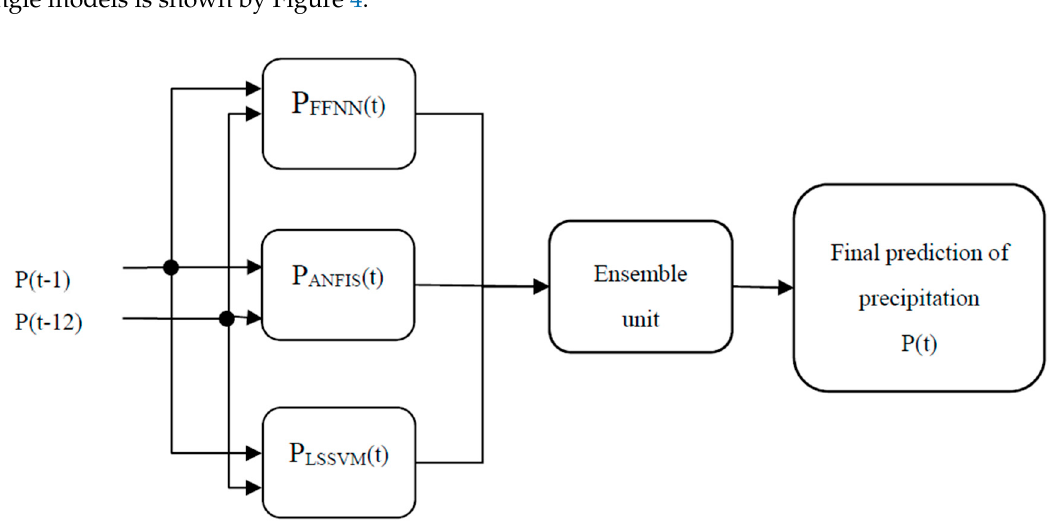
Figure 4. Conceptual model of the ensemble system in scenario 1.